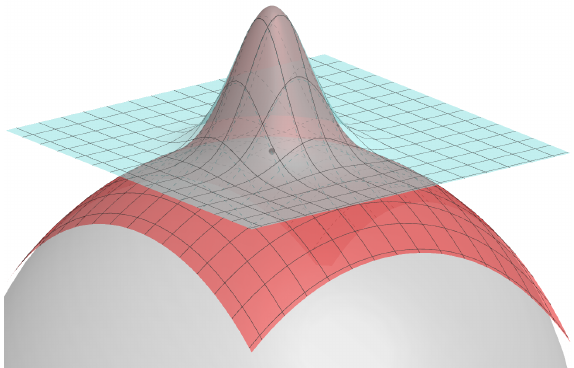
Figure 1: The logarithm of X at the origin of the Lie alge- bra (blue surface) approximates the Gaussian dis- tribution at the group identity (red surface) if the distribution is tightly focused near the identity.